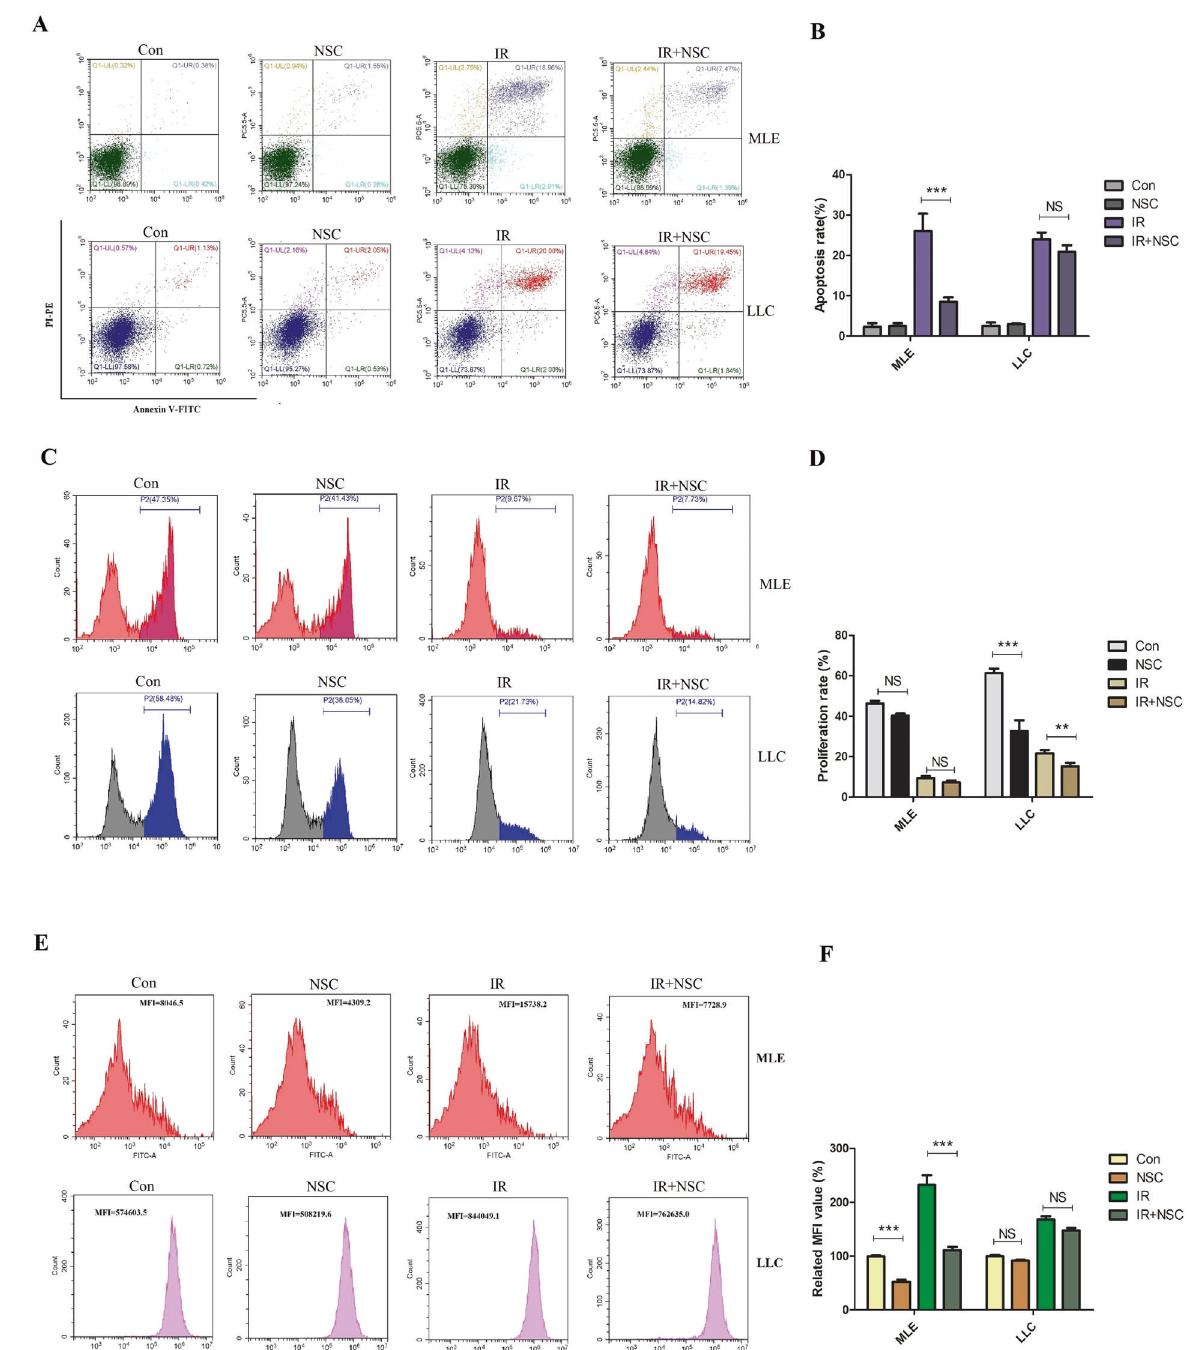
Fig. 7 The effects of Rac1 inhibition on the apoptosis, proliferation and ROS levels of MLE and LLC. MLE and LLC were pretreated with PBS or NSC23766 (NSC, 100 μ M) for 2 h and then went through 10 Gy of radiation. 24 h later, the apoptosis ratio ( A ) and potential of proliferation ( C ) were detected by Annexin V/PI method and Edu labeling with fl ow cytometry, respectively. At 6 h after radiation, the ROS content ( E ) was detected by ROS probe with fl ow cytometry. Panels B , D , and F were the quanti fi cation for A , C , and E , respectively. *** represented P < 0.01 and 0.001 between the corresponding groups, respectively. The error value was expressed as mean ± SEM. Experiments were repeated three times. Subcutaneous tumor-bearing of nude mice volume (mm 3 ) was calculated as the longest diameter (mm) × the shortest Twenty male BALB/cJGpt-Foxn1 nu /Gpt mice were randomly divided into diameter (mm) 2 . two groups, namely the control group and the Rac1 knockdown group ( N = 10). After ear labeling, mice were subcutaneously injected with 1 × Orthotopic lung tumor-bearing mouse model 10 6 of corresponding LLC cells on the right hind leg. The control group was 70 male C57BL/6 were randomly divided into two main groups, the NC injected with Rac1-NC LLC and the Rac1 knockdown group with Rac1-SH group, and the SH group ( N = 35). Two kinds of LLC cells, namely the LLC. The size of each mouse ’ s tumor was measured with a vernier caliper Rac1-NC LLC (control) and the Rac1-SH LLC (Rac1 knockdown), were on the 12 th , 15 th , 18 th , 21 st , and 24 th days after tumor-bearing. Tumor Cell Death Discovery (2022)